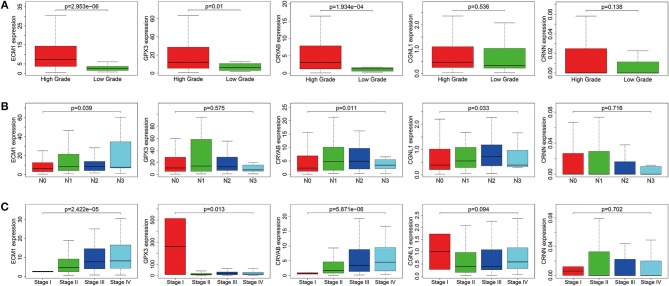
Expression levels of ECM1, GPX3, CRYAB, CGNL1, and CRNN in different clinicopathologic characteristics. (A) Histological grade; (B) pN (pathological N) stage; and (C) UICC (Union for International Cancer Control) stage.